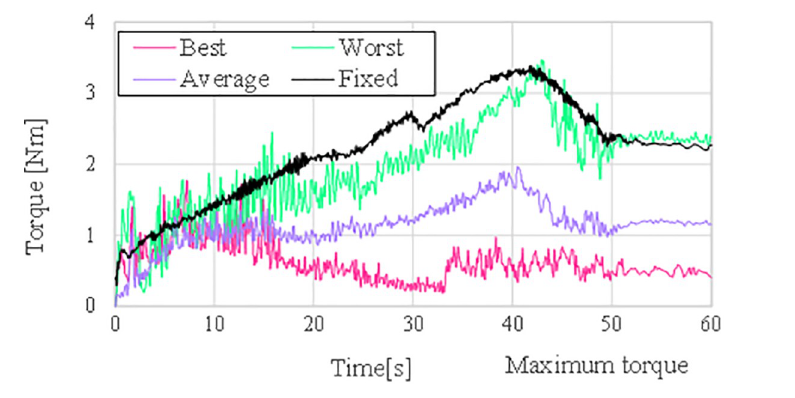
Fig 13. Maximum value among manipulator joints over time.